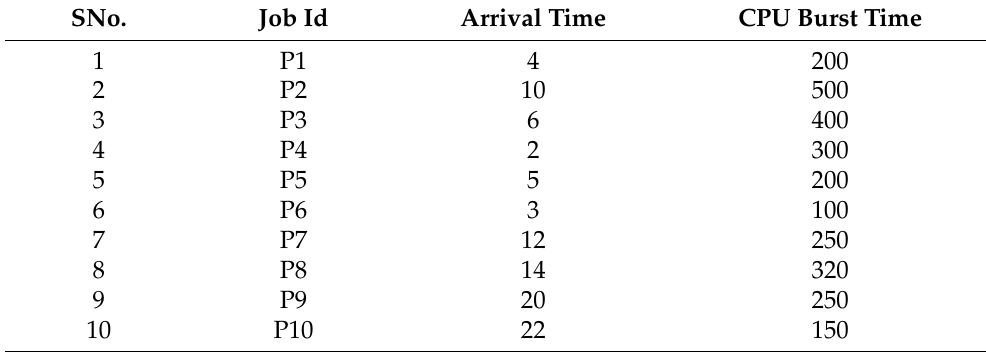
Table 4. Sample Workload.